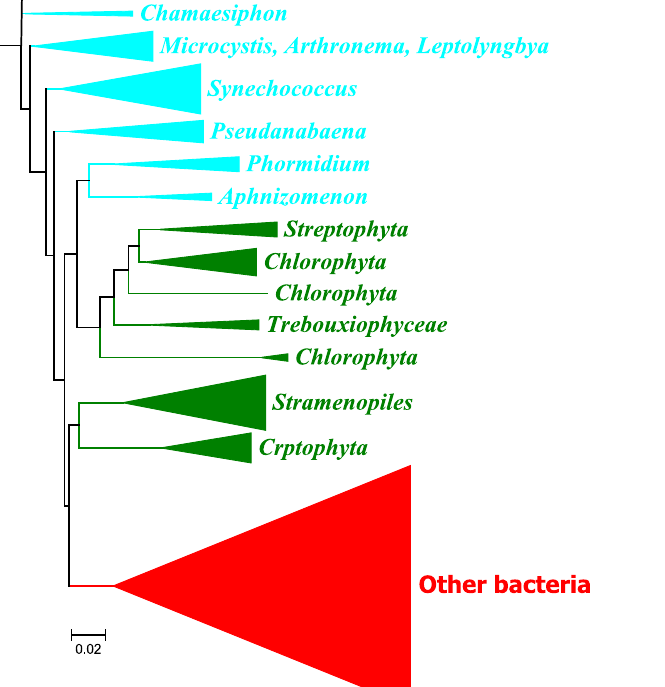
Fig 2. Neighbor joining phylogenetic tree of microbial communities identified from eight reservoirs and one streamsurveyedin this study based on 16rDNAamplified with cyanobacteria primers (tree details are shown in S1 Fig). Cyanobacteria, eukaryoticphytoplankton and other bacteria are marked in blue, green and red, respectively.